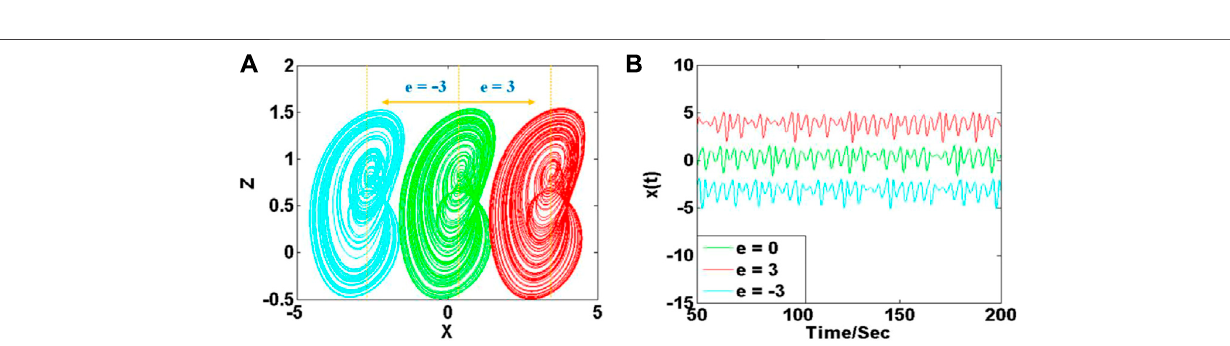
FIGURE6| Lyapunov exponents and bifurcation diagrams ofsystem(2) with a (cid:1) 2.4, b (cid:1) 0.5, c (cid:1) 1.7and initialcondition (1, 0, 1)when the memristor parameter d varies in [0, 5]. (A) bifurcation, (B) Lyapunov exponents.